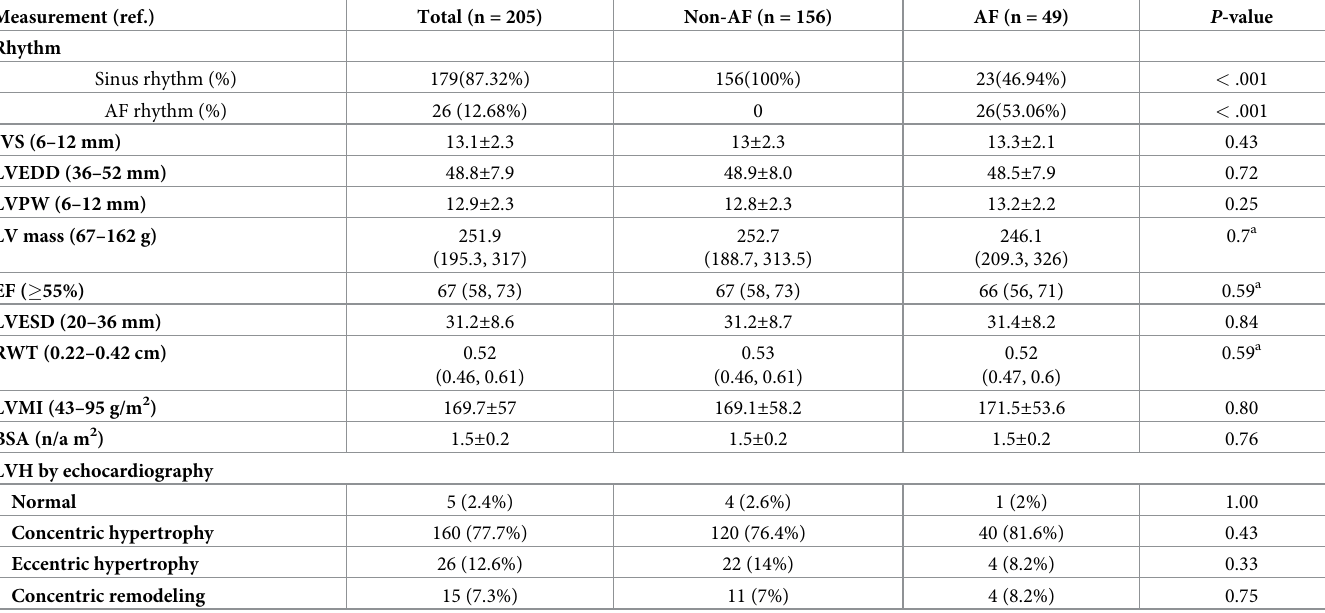
Table 3. Pre-dialytic echocardiographic profiles of incident hemodialysis patients. Measurement (ref.)